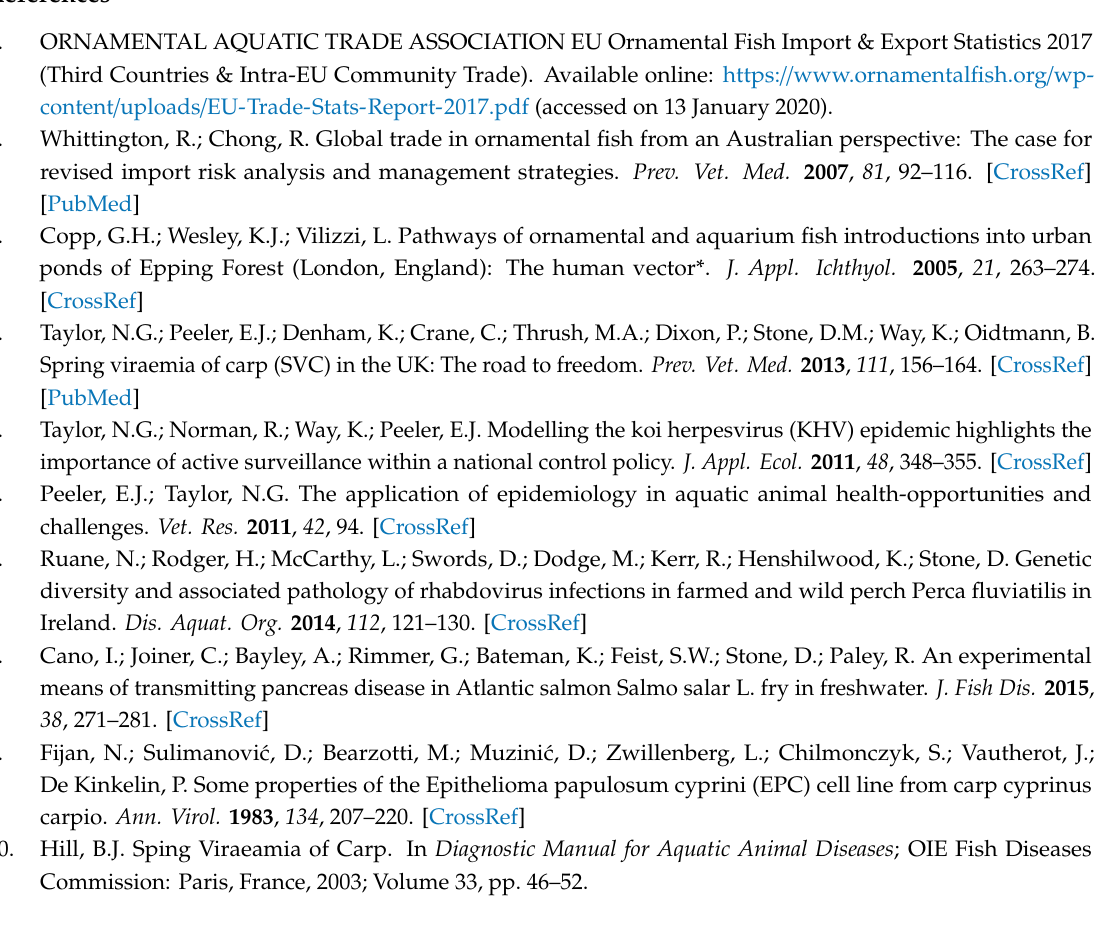
Figure S1: Taqman qPCR detection of goldfish nidovirus. Figure S2: Neutralisation